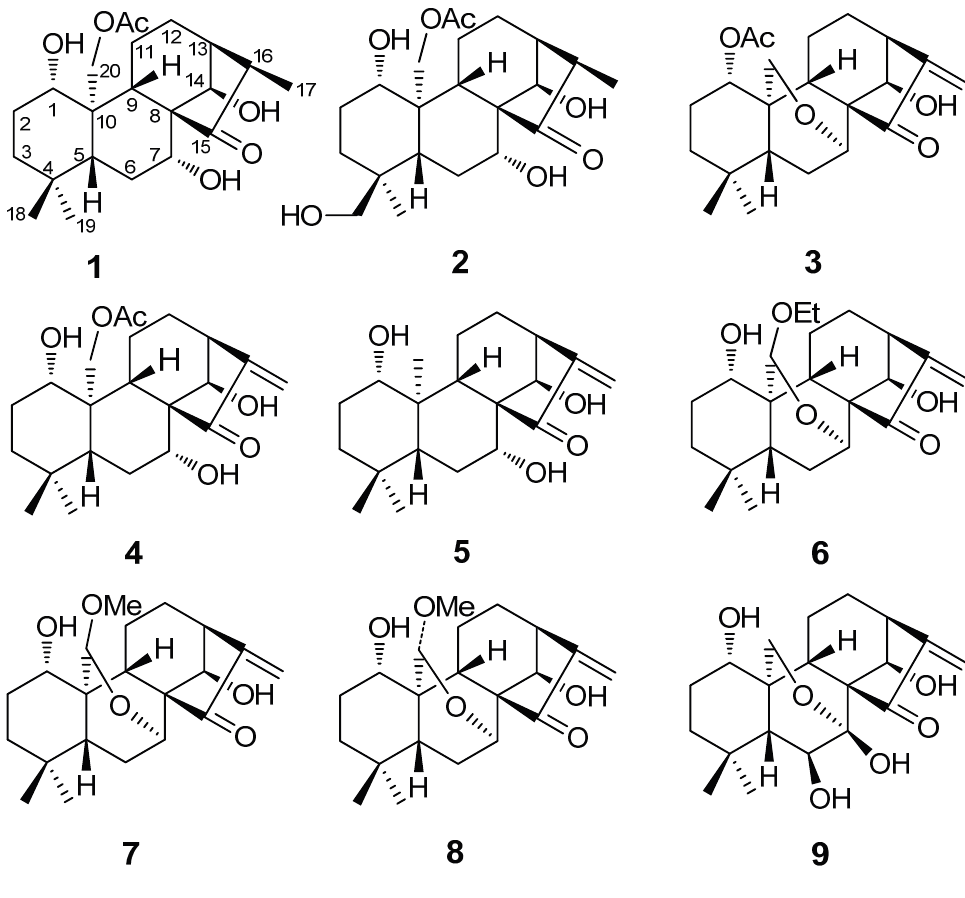
Figure 1. Structures of compounds 1 – 9